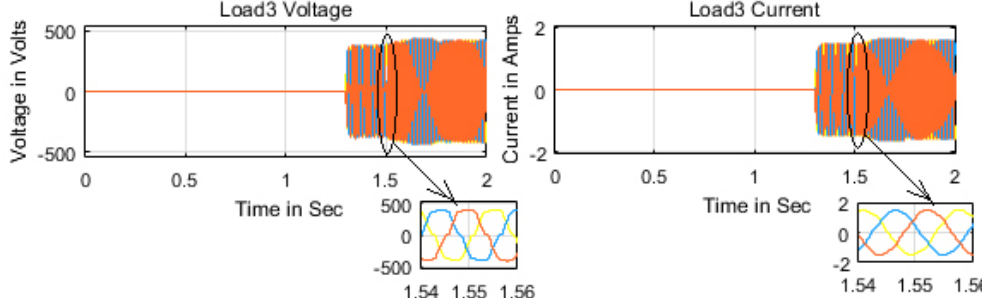
Figure 25. Load3 Voltage & Current.